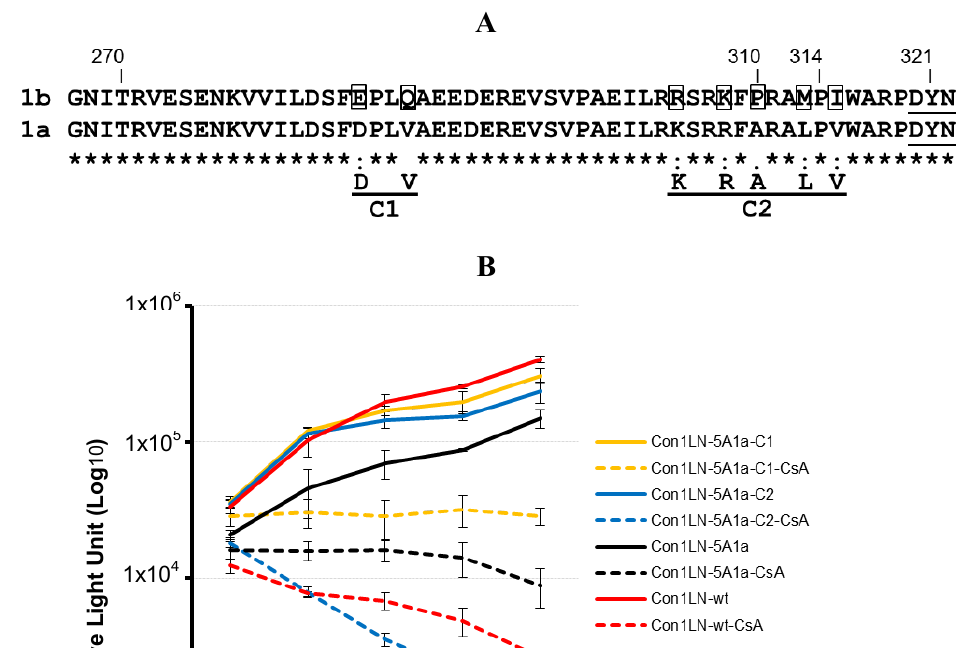
Figure 3. Mutational analysis of Con1bLN-5A1a chimeric replicons reveal linear NS5A regions that alter CsA susceptibility. ( A ) The HCV 1b (358 isolates) and 1a (224 isolates) amino acid sequences were retrieved from the European HCV Database and subjected to amino acid homology analysis using web based program . The amino acid alignment analysis was performed on 53 amino acids N-terminal to the DYN region of HCV NS5A from 1b and 1a genotypes. The highly conserved DYN region is underlined. Site-directed mutagenesis was performed in two cluster regions, C1 and C2, in Con1bLN-wt replicon to make it similar to genotype 1a. The boxed residues were substituted in 1b replicon with genotype 1a amino acids. Amino acids of interest are numbered. The amino acids of interest are numbered. ( B ) The CsA susceptibility replication assay was performed on replicons Con1bLN-1aC1, Con1bLN-1aC2, Con1bLN-5A1a and Con1bLN-wt replicons. ( C ) The percent inhibition of respective replicons in (B) were calculated and